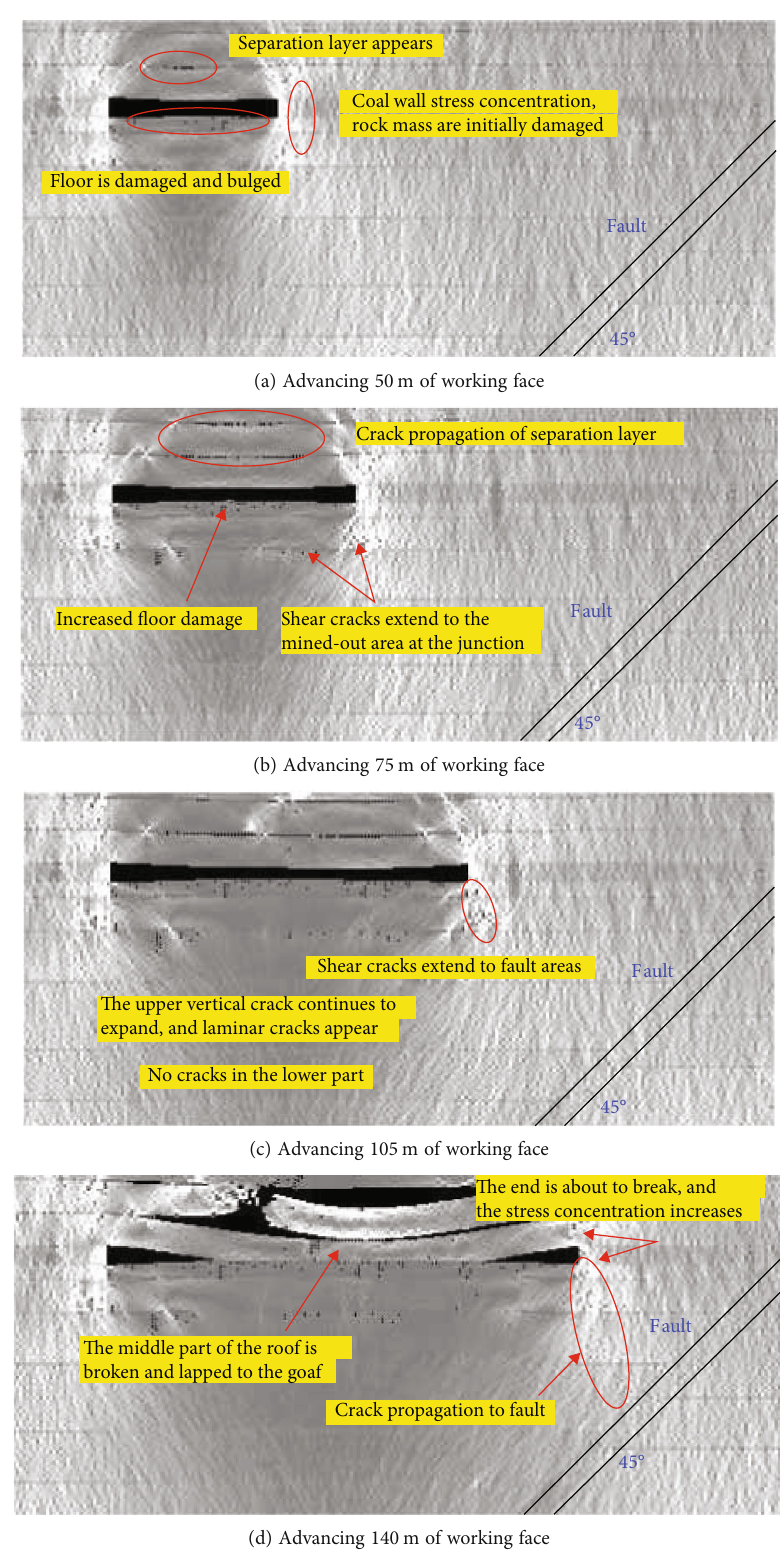
Figure 7: Mining crack evolution process (45 ° , project